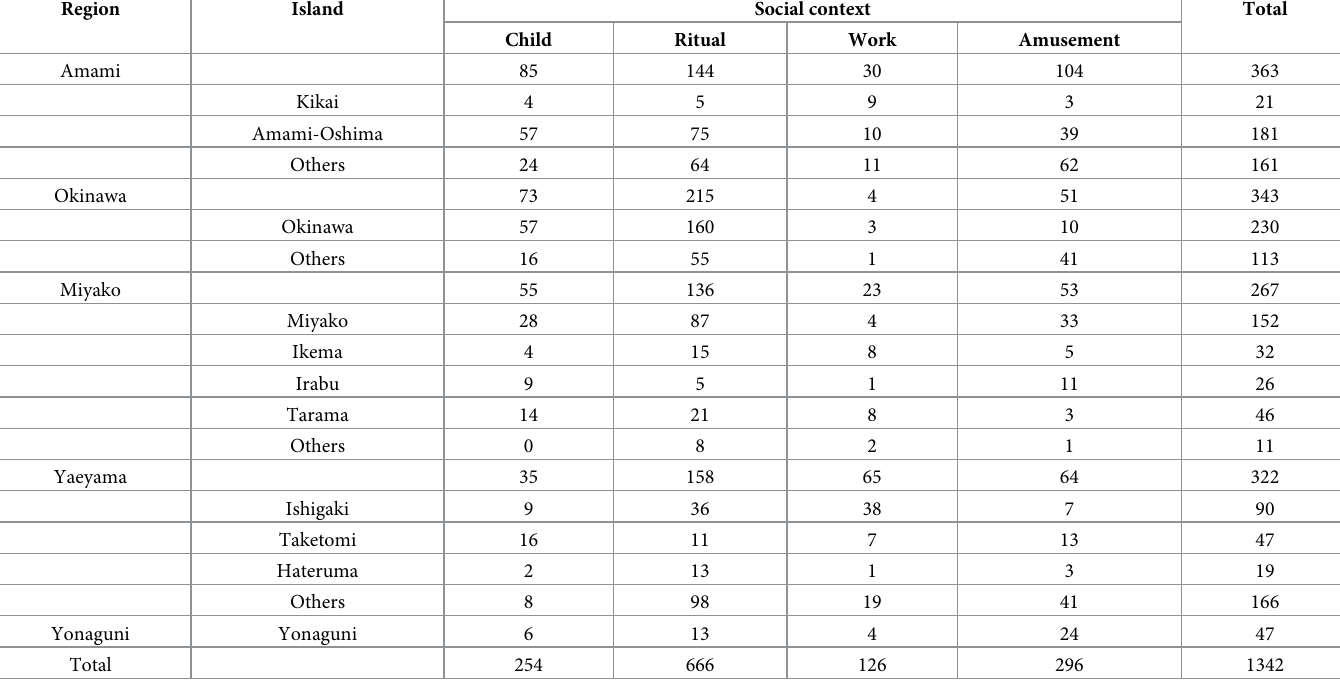
Since neither linguistic nor genetic data existed in the islands lumped together in "others," songs from these islands were excluded from the analysis by island, although they were included in the analysis by